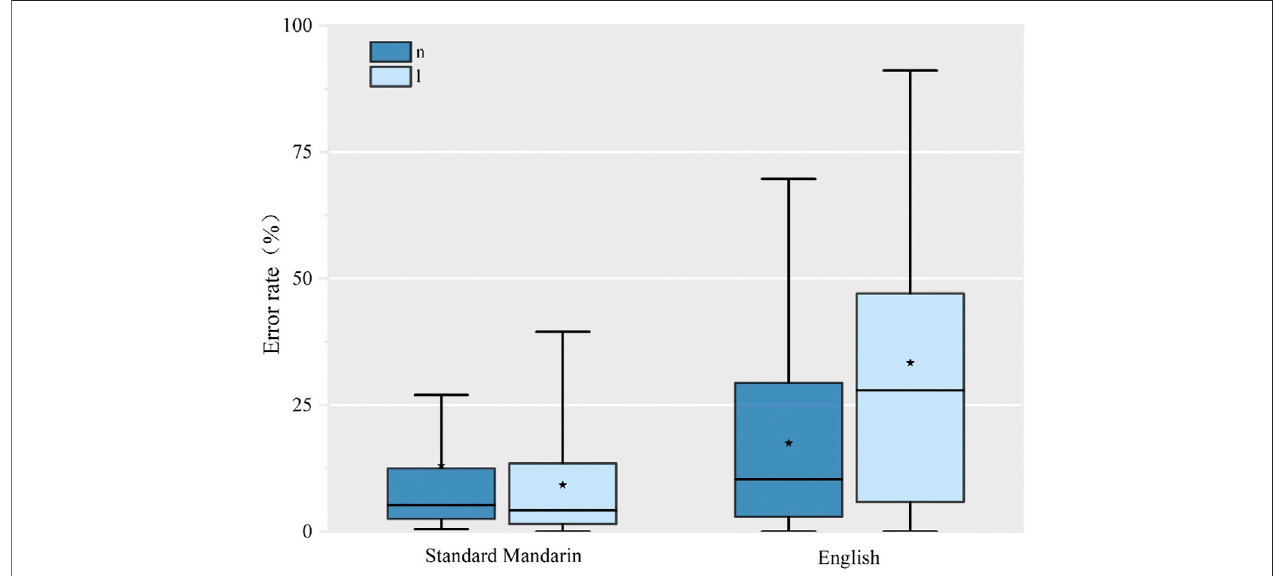
FIGURE 9 | Error rate of production of words with initial /n/ and /l/ in Standard Mandarin and English.